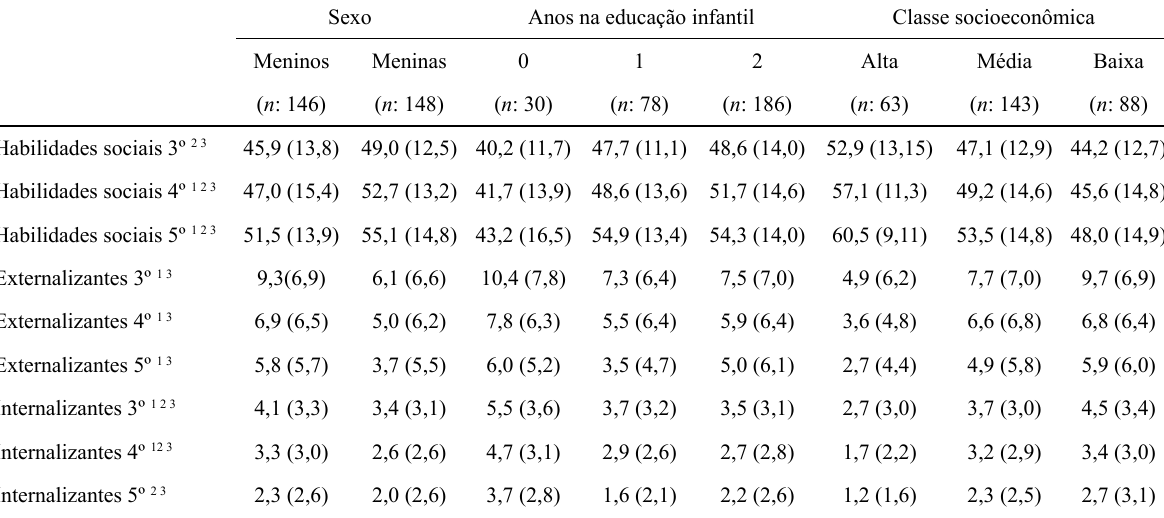
os desvios-padrão das variáveis do